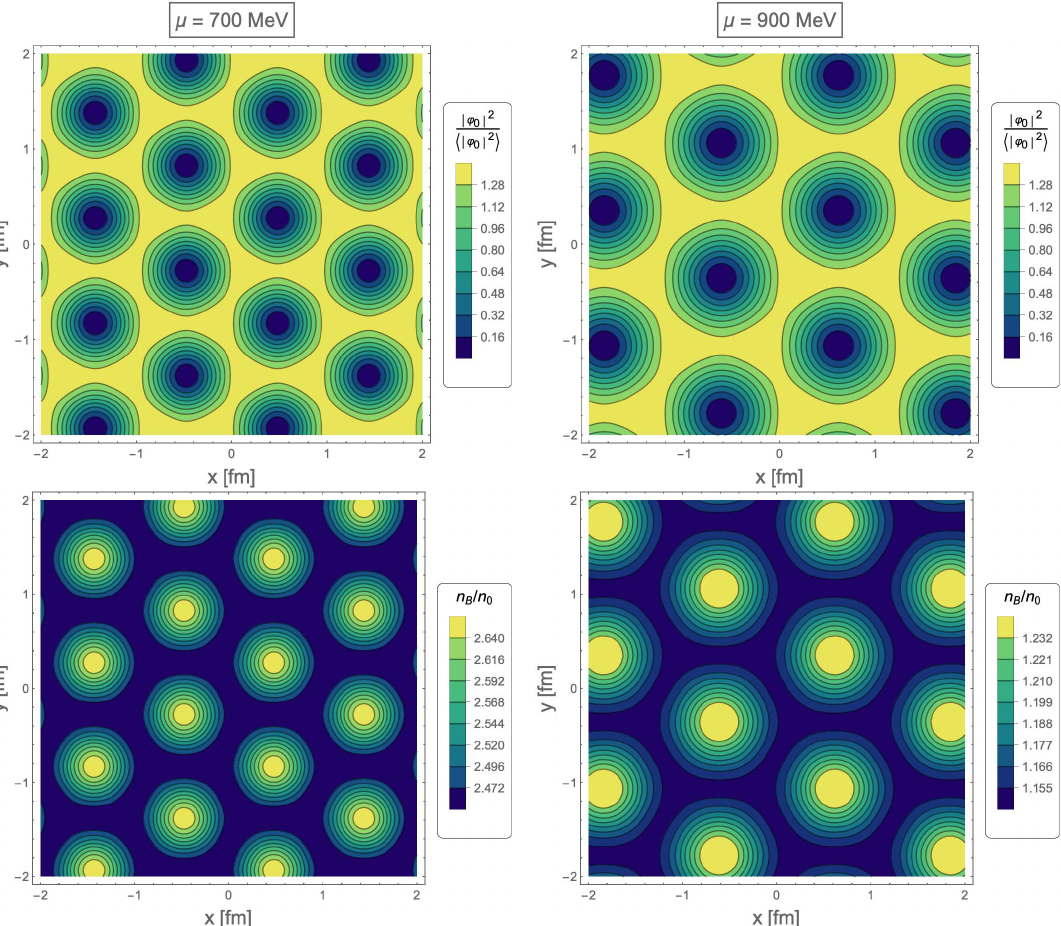
Figure 2 . Upper panels: modulus of the charged pion condensate (squared) normalised to its spatial average in the plane perpendicular to the magnetic field. The plots show the energetically preferred hexagonal lattice structure just above the critical magnetic field, in both panels h B i = 1 . 01 B c 2 , where eB c 2 ’ 0 . 2319 GeV 2 for a baryon chemical potential µ = 700 MeV (left panel) and eB c 2 ’ 0 . 1403 GeV 2 for µ = 900 MeV (right panel). The distance between the minima turns out to be about 1 . 10 fm (left) and 1 . 42 fm (right). Lower panels: baryon number density in units of the nuclear saturation density n 0 for the same µ and h B i as the corresponding upper panels. We have used the numerical values f π = 92 . 4 MeV and n 0 = 0 . 15 fm − 3